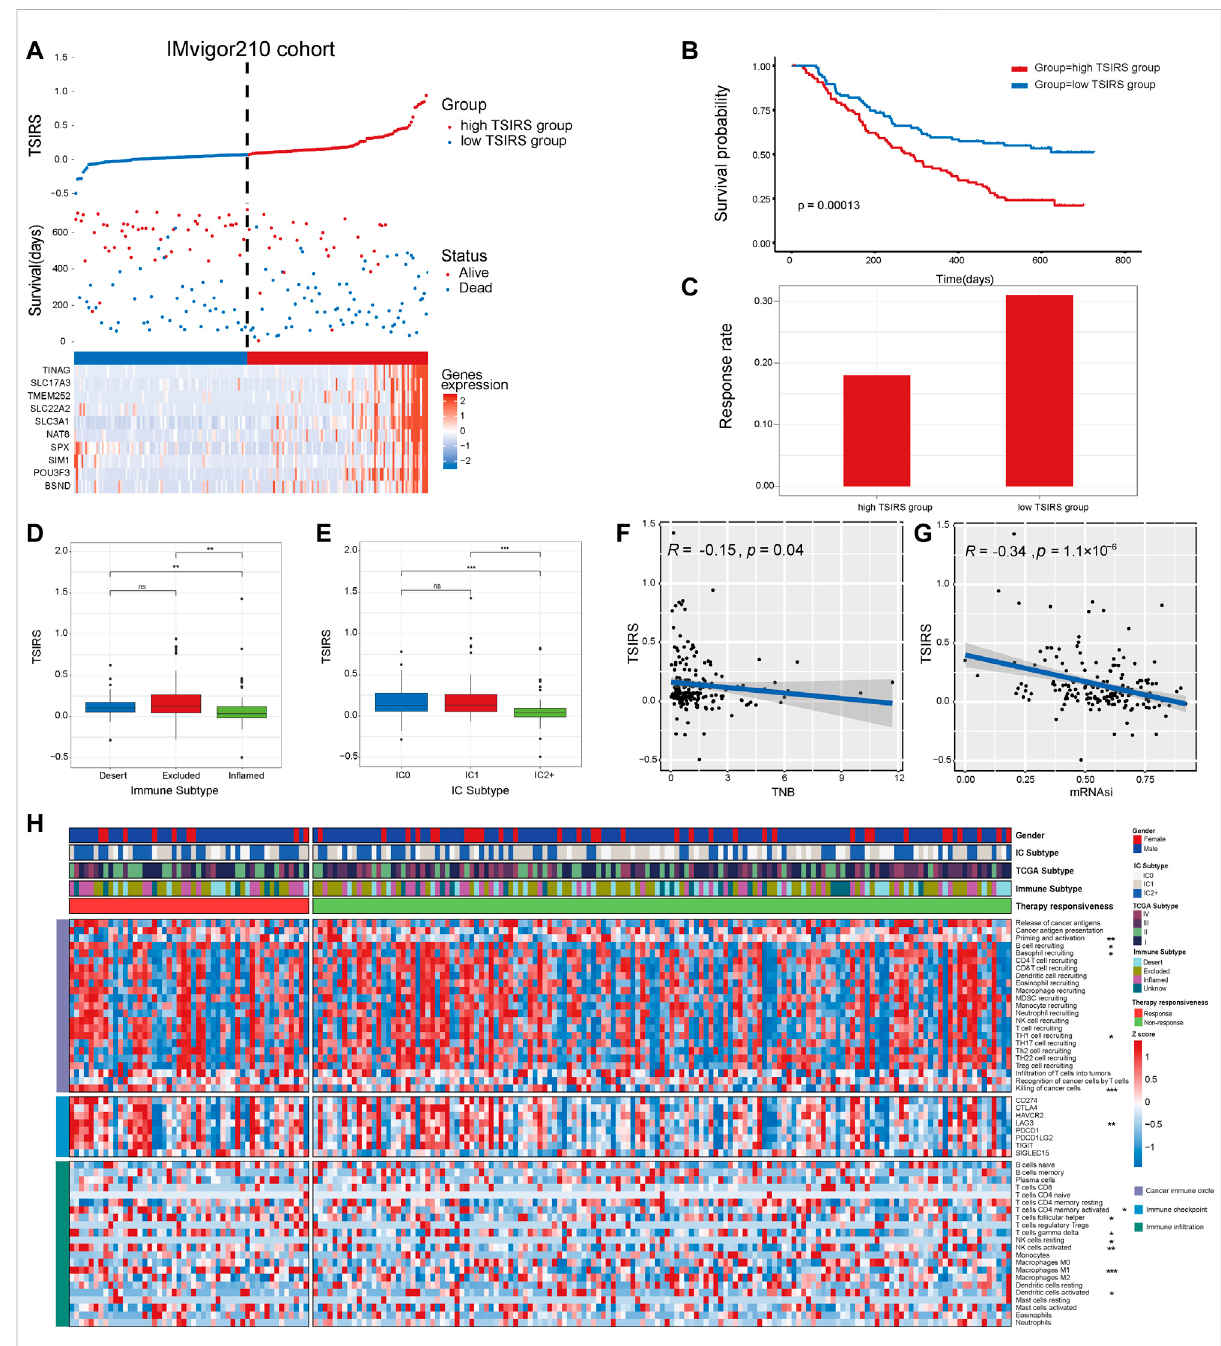
FIGURE 4 TSIRSpredictspatientprognosisinthetrainingcohort. (A) DistributionofthehighTSIRSgroupandthelowTSIRSgroupinIMvigor210cohort. (B) Comparison of patient prognosis of the high TSIRS group and the low TSIRS group in IMvigor210 cohort. (C) Patient therapy responsiveness rate of the high TSIRS group and the low TSIRS group in IMvigor210 cohort. (D,E) Comparison of patient TSIRS in different immune (D) and IC (E) subtype. (F,G) CorrelationbetweenTSIRSandTNB (F) andmRNAsi (G) . (H) Comparisonofpatientcancerimmunecirclerelatedprocessactivity,immune checkpoint expression and immune in fi ltration level. * p < 0.05, ** p < 0.01, *** p < 0.001. TNB, Tumor neoantigen burden; mRNAsi, mRNA stemness